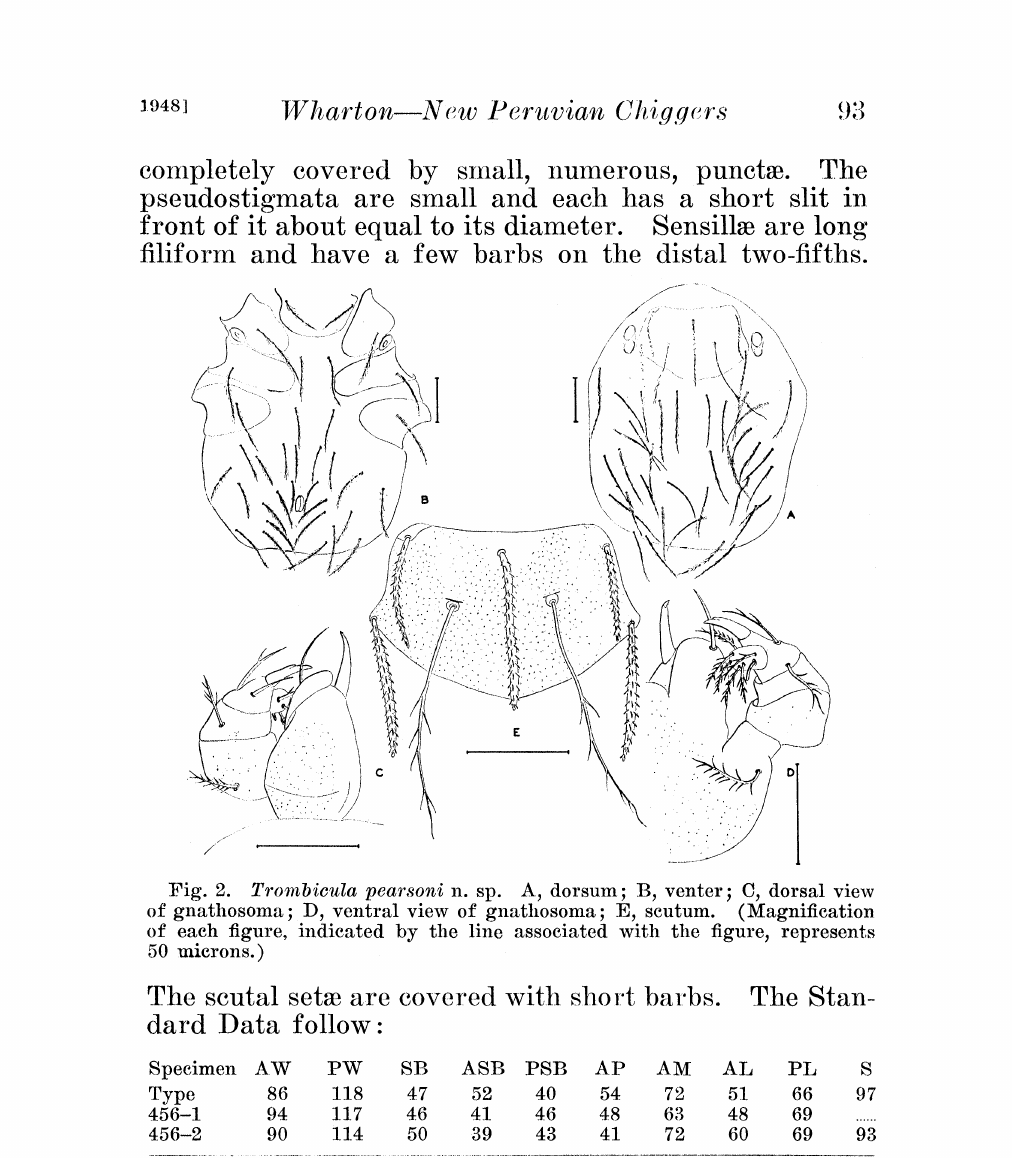
of each figure, indicated by the line associated with the figure, represents 50 microns.) The scutal setm are covered with short